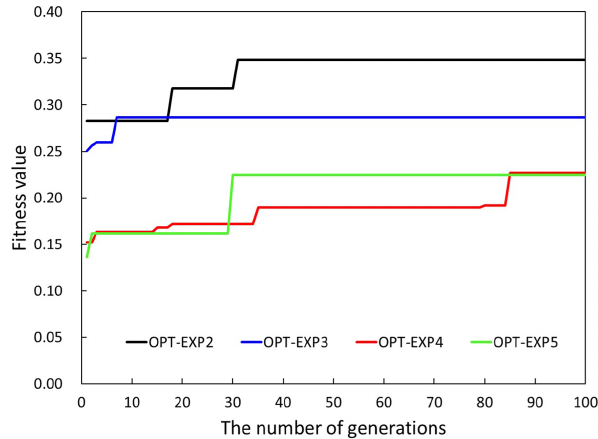
Figure 7. Same as Fig. 3 but for OPT-EXP2 to